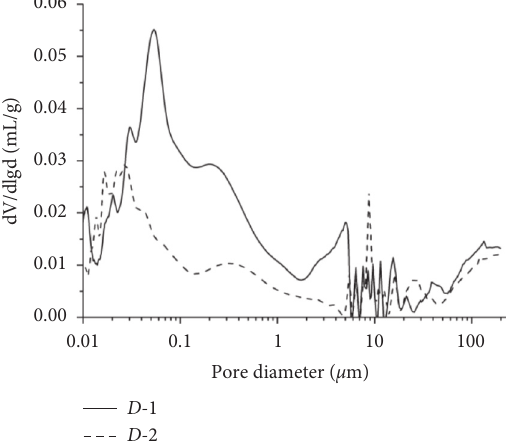
Figure 8: Pore size distributions of sample D -1 and D